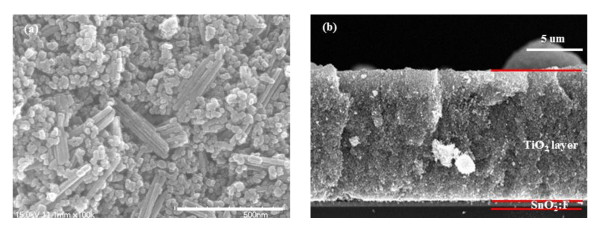
Cross-sectional (a) and top-view (b) FE-SEM images of the TiO2 nanoparticle/TNT composite layer.